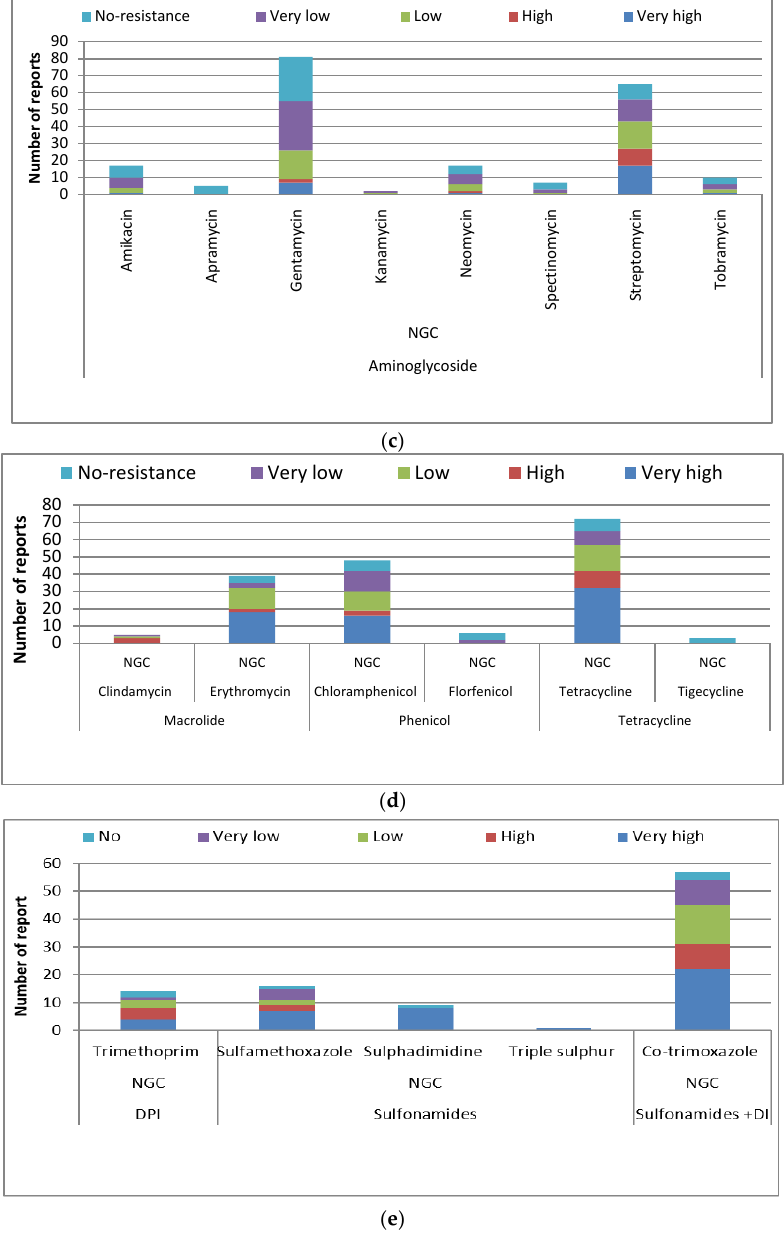
Figure 3. Number of reports of antimicrobial resistance levels of ( a ) β -lactam derivatives, ( b ) Quinolones; ( c ) Aminiglycosides; ( d ) Macrolides, Phenicols, and Tetracyclines; and ( e ) Sulfonamides derivatives antimicrobials.